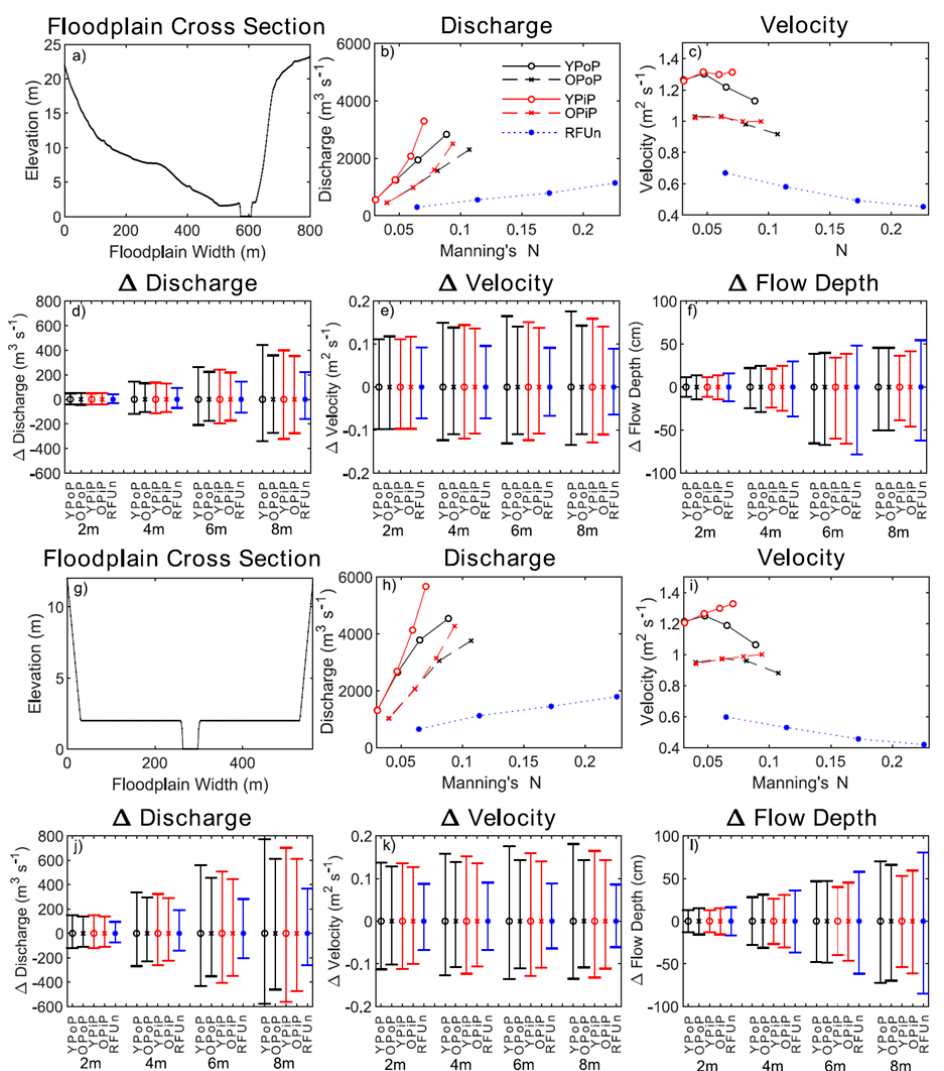
Figure 4. Uncertainty in Discharge, depth-averaged Velocity, and Flow Depth propagated from the uncertainty in Manning’s n roughness from combined mean literature errors in stem density, DBH, WAI, and LAI (see Figure 3a). Flow through two cross-sections are given where panel ( a ) is directly upstream of the River Avon at Evesham; and ( g ) is a generic flat floodplain with a width of 500 m. Discharge and Velocity in ( b ),( h ),( c ),( i ) are calculated at 2, 4, 6, and 8 m floodplain depth using the Manning’s n equation, where roughness is given as the control roughness of the 5 floodplain forest types (see Figure 1). Changes in Discharge ( d ),( j ), depth-averaged Velocity ( e ),( k ) and Flow Depth ( f ),( l ) are presented by forest types and by control flow depth over the floodplain. Figure 1). Changes in Discharge ( d , j ), depth-averaged Velocity ( e , k ) and Flow Depth ( f , l ) are presented by forest types and by control flow depth over the